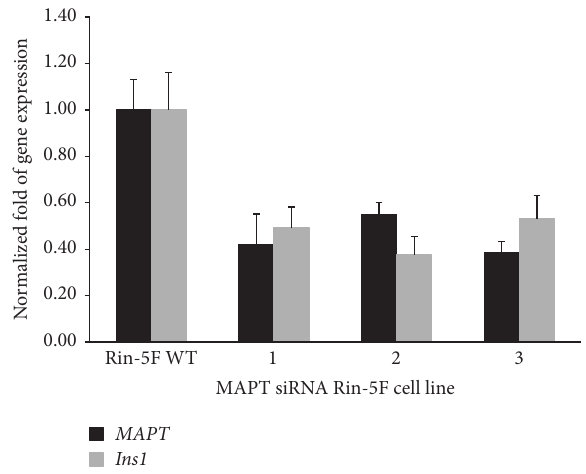
Figure 8: MAPT knockdown. RT-qPCR of RNA isolated from three different MAPT siRNA transduced Rin-5F cell lines (marked as numbers 1, 2, and 3). The rat endogenous Mapt and Ins1 gene expression level was evaluated using the ΔΔ CT